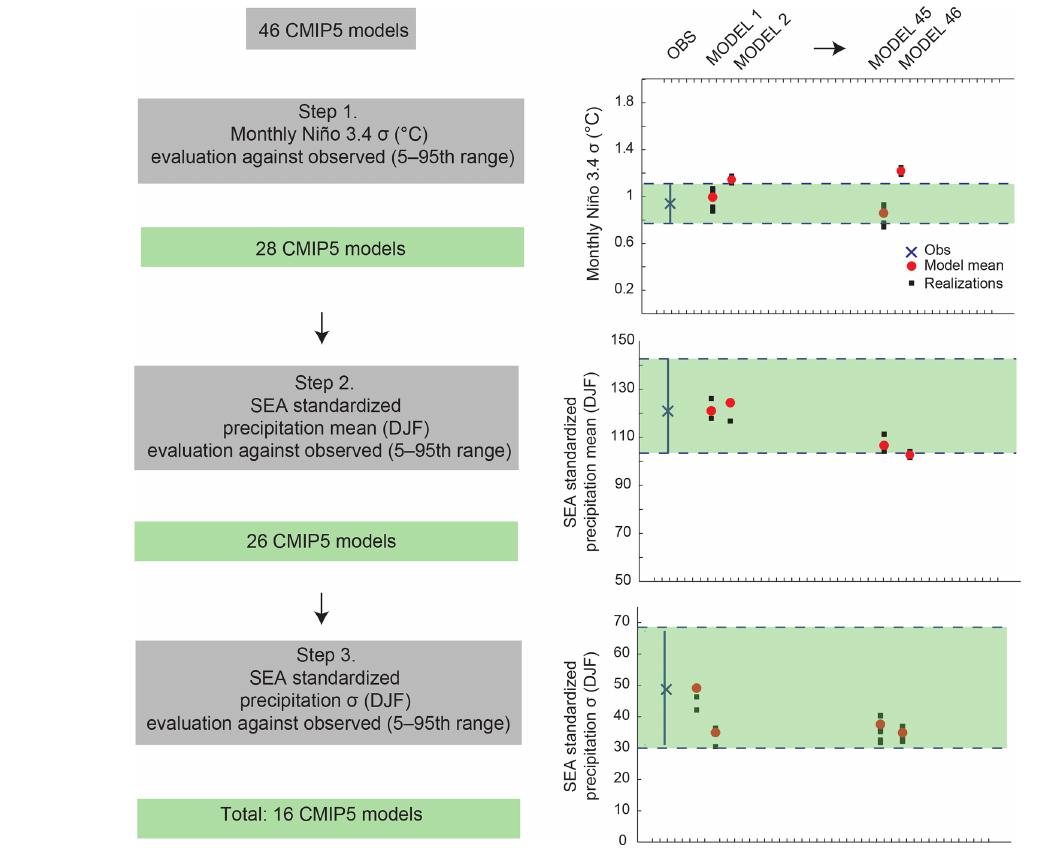
Figure 2. Schematic of the three-step CMIP5 model evaluation used for examining influences on heavy rainfall of 2010–2012. Left-hand side shows flowchart evaluation steps (for the NINO3.4 index and south-eastern Australian (SEA) rainfall in December–February (DJF)) and the number of models suitable, and right-hand side demonstrates evaluation of model realizations against observations for the metrics